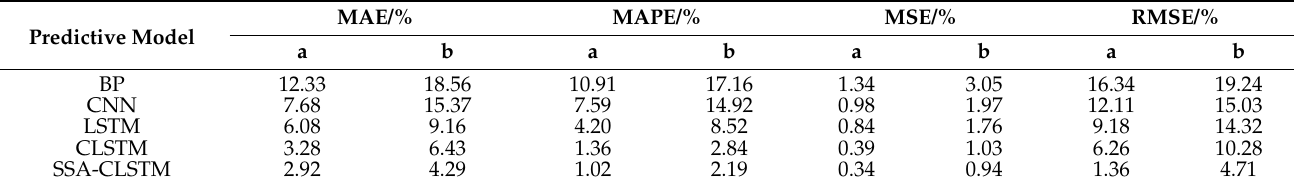
Table 1. Errors of different prediction models under two weather